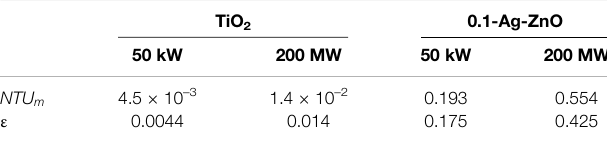
TABLE6| NTU m and ε of50 kWand200 MWSUT.TABLE6NTU m and ε of50 kW and 200 MW